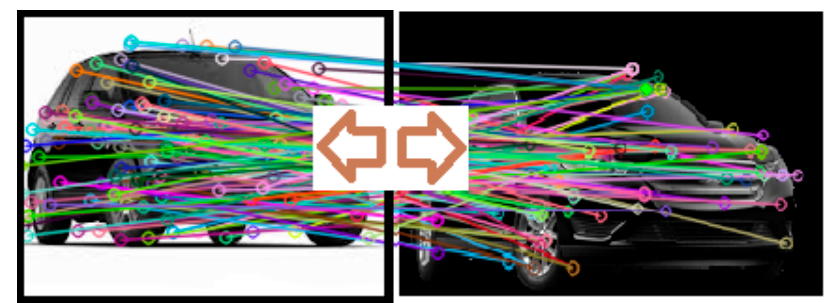
Figure 11. SURF descriptors.